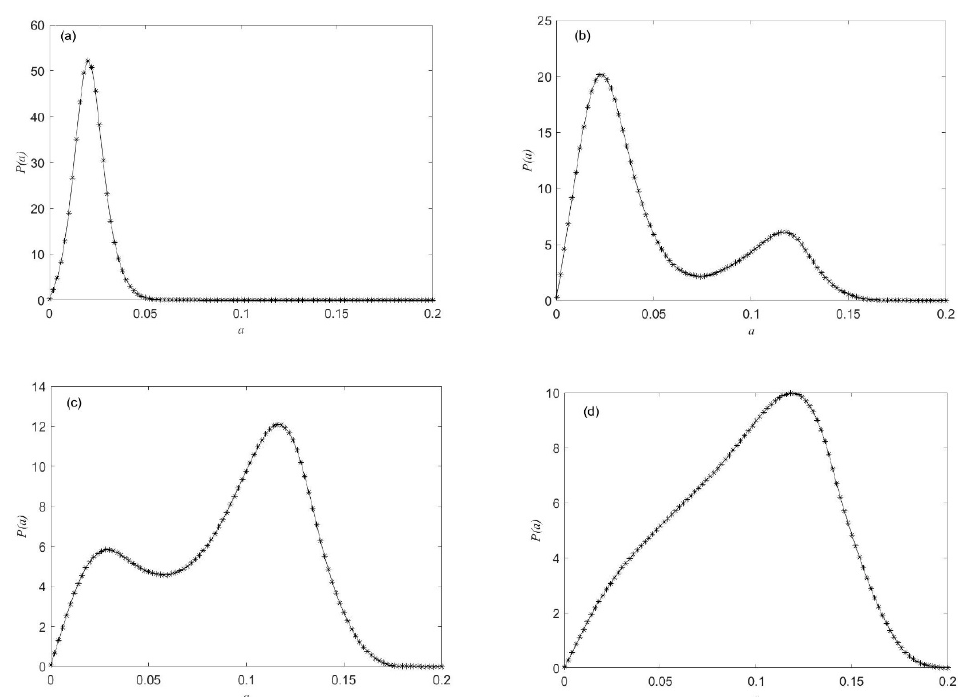
Figure 7. The stationary PDFs P ( a ) of amplitude a for the original SMA oscillator system (11) with Figure 7. The stationary PDFs 𝑃(𝑎) of amplitude 𝑎 for the original SMA oscillator system (11) with the fixed system parameters 𝜁 = 0.1 , 𝛽 = −1.3 × 10 (cid:2871) , 𝛾 = 4.7 × 10 (cid:2873) , 𝜃 = 1.9, 𝑓 = 0.6 , Ω = 2.0 , and the fixed system parameters ζ = 0.1, β = − 1.3 × 10 3 , γ = 4.7 × 10 5 , θ = 1.9, f = 0.6, Ω = 2.0, and different noise intensities ( a ) ℎ = 0..05 ; ( b ) ℎ = 0.1 ; ( c ) ℎ = 0.15 ; ( d ) ℎ = 0.3 . The initial conditions different noise intensities ( a ) h = 0.05; ( b ) h = 0.1; ( c ) h = 0.15; ( d ) h = 0.3. The initial conditions are . are set to 𝑥(0) = 0.01 , 𝑥(cid:4662)(0) = 0.01 , corresponding to the low-amplitude oscillation state. x ( 0 ) = 0.01, corresponding to the low-amplitude oscillation set to x ( 0 ) = 0.01,